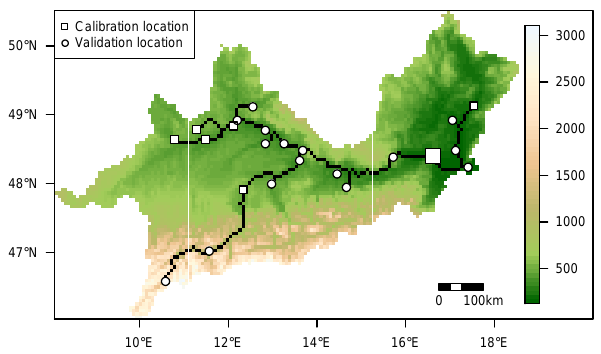
Figure 1. Digital elevation map of the Upper Danube catchment, colours indicate elevation (m), indicated in black is the river net- work, square symbols indicate locations for calibration on discharge observations, circles indicate locations for validation on discharge observations. The large square near the outlet (right) is the location used for calibration if only one discharge time series is used ( Q 1 and Q 1 sat ).